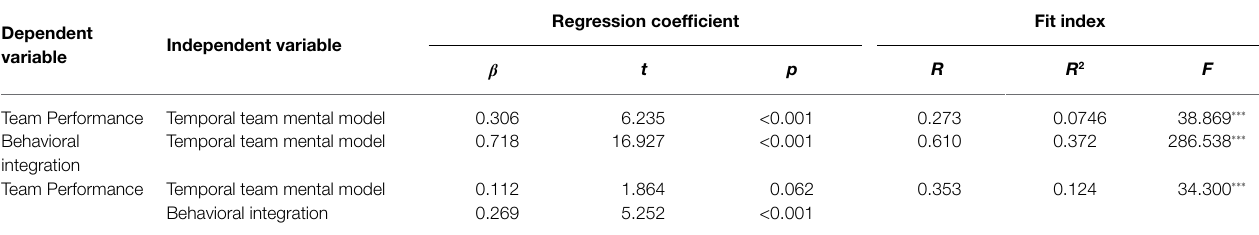
TABLE 3 | Mediating effect test of behavioral integration.